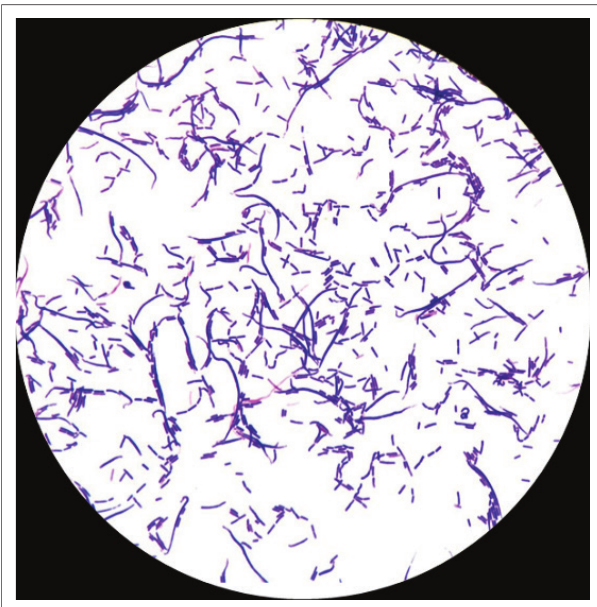
FIGURE 2: Microscopic image at 1000 × magnification showing boxcar- shaped, Gram-positive bacilli, typical of Bacillus cereus (Pretoria, South Africa, 19 March